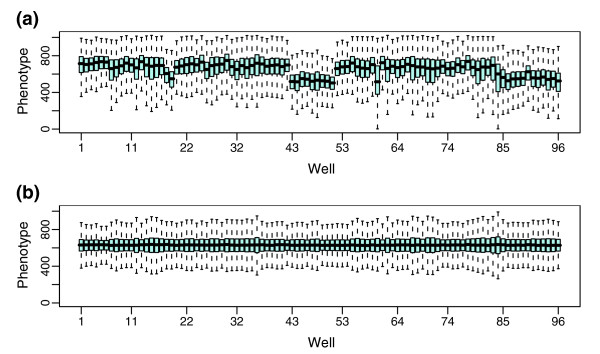
Systematic variation in signal intensities. (a) Box plot of raw fluorescence values measuring the phenotype for a 96-well microtiter plate. Differences in the mean values are identified for individual wells, and several wells are affected by a block effect. (b) Data after normalization.